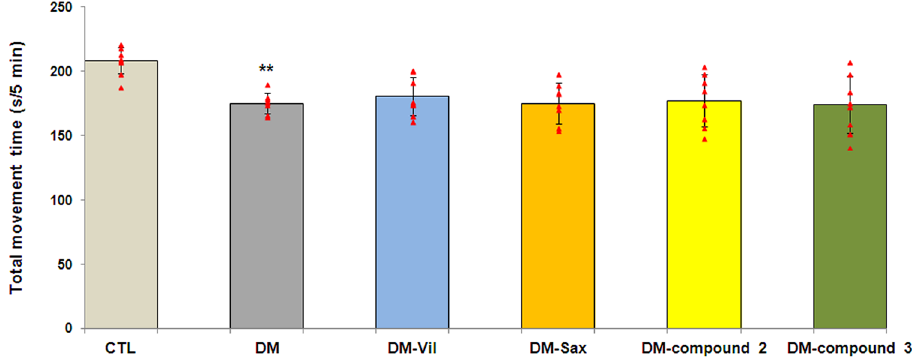
Figure 1. Spontaneous locomotor activity of mice in the open field test. Total movement time of mice (in seconds), over the whole area of the box, during 5 min of observation. Bars in figure illustrates experimental groups— CTL non-diabetic mice, DM diabetic mice, DM‑Vil vildagliptin-treated mice [20 mg/kg, po ], DM‑Sax saxagliptin-treated mice [10 mg/kg, po ], DM‑compound 2 compound 2-treated mice [50 mg/kg, po ], DM‑compound 3 compound 3-treated mice [50 mg/kg, po ], respectively. Each column represent means ± SD (n = 8). One-way ANOVA, followed by Tukey’s post hoc test was used. **p < 0.01 as compared with